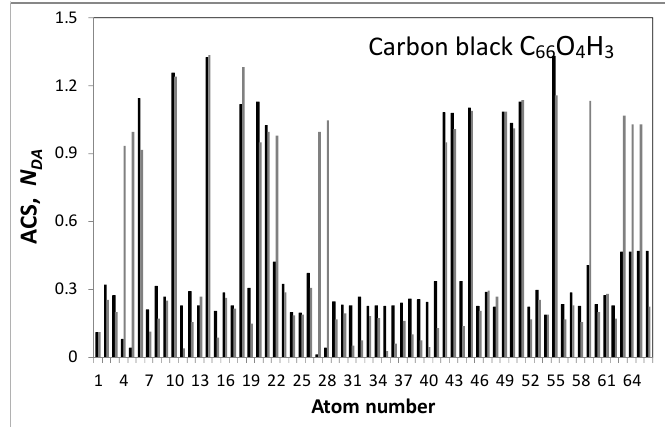
Figure 3. ACS N DA distribution over carbon atoms of the (5,5) NGR (light gray) and GOH Figure 3 . (black)